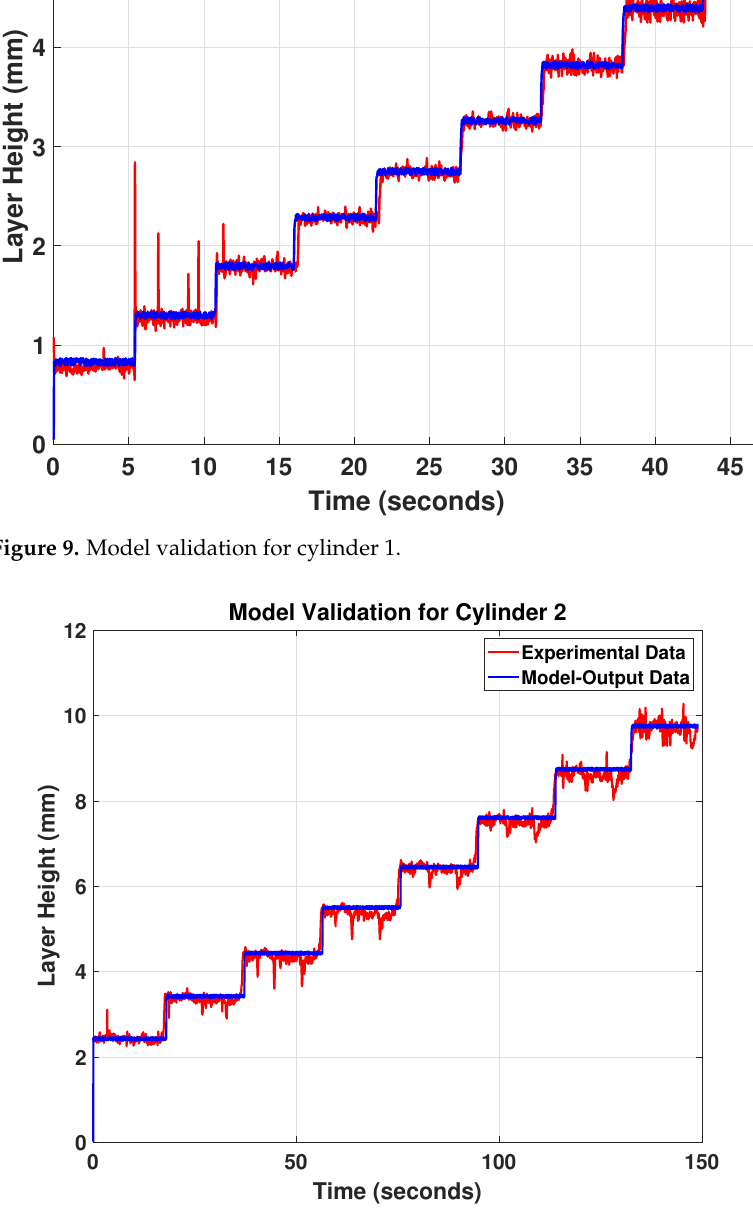
Figure 10. Model validation for cylinder